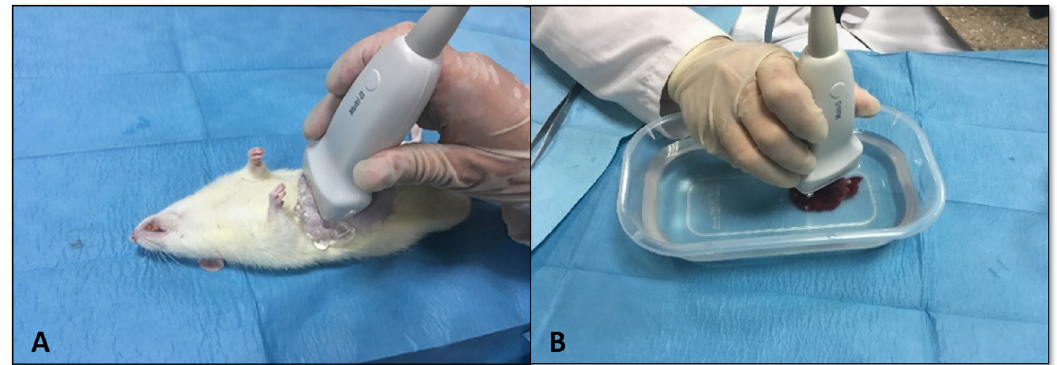
Fig 1. A , In vivo ultrasound study with the animal placed in decubitus. B , Ex vivo ultrasound study using the immersion